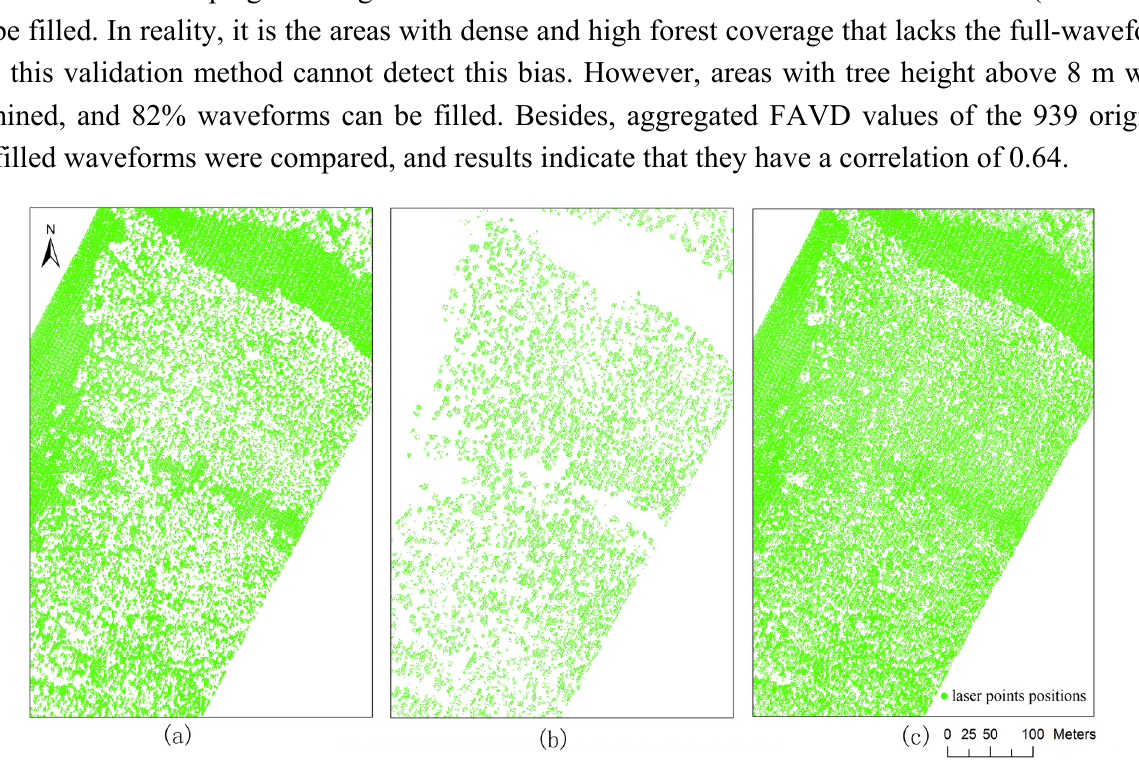
Figure 5. Positions of the laser shots ( a ) original ( b ) filled using the ancillary CHM data ( c ) original and